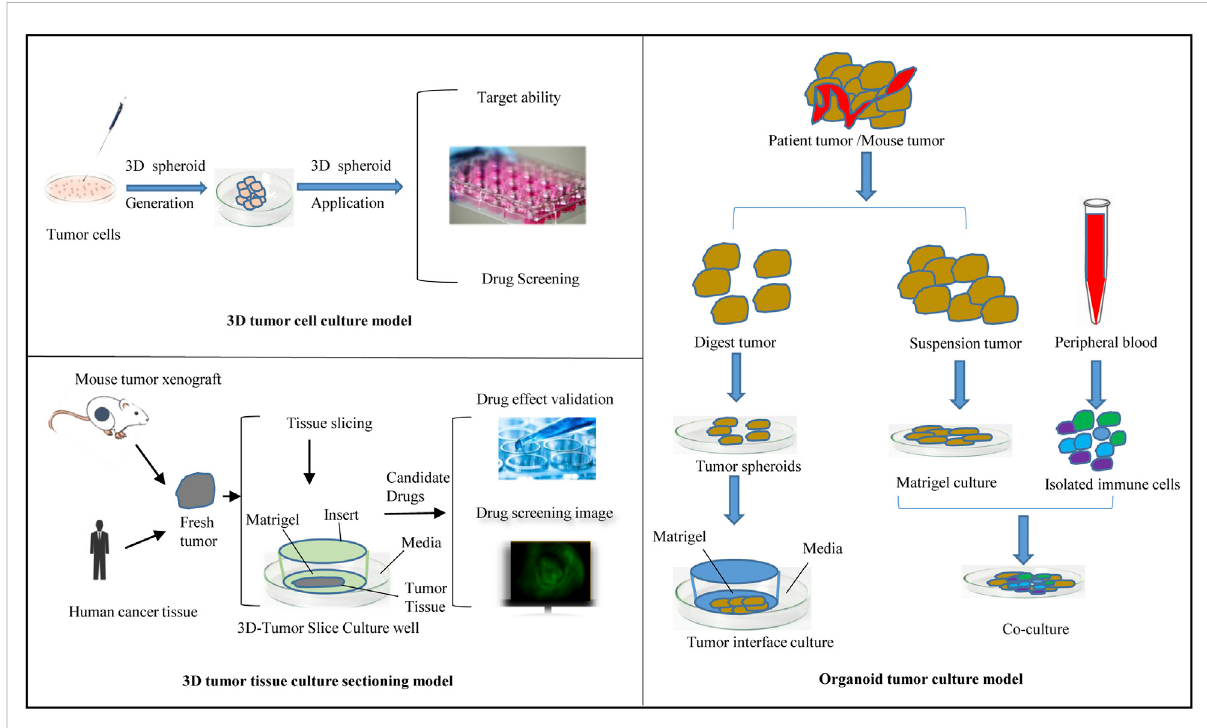
FIGURE 2 Types of 3D tumor culture process in xenograft and human model.